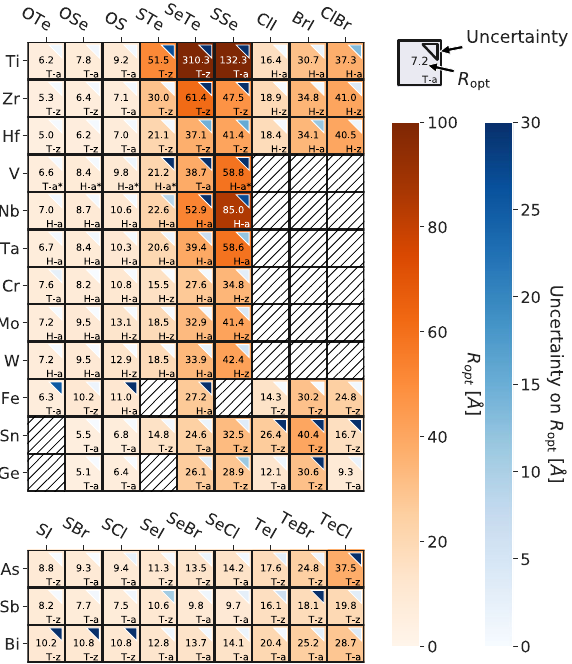
Fig. 3 Overview of the 135 investigated materials and their extrapolated optimal radius. Overview of the 135 investigated materials and their extrapolated optimal radius according to Eq. (2). It is ensured that at least three data points after fi ltering according to the criteria described in the Supplementary Note 1 exist (otherwise marked with a hatched box). The asterisk indicates that the difference in energy between the H-/T- phase is <10 meV/atom and that the smaller optimal tube radius is chosen given the extrapolated optimal radius from both prototypes. The lowercase letters a/z indicate which wrapping direction (armchair/zigzag) is preferred.